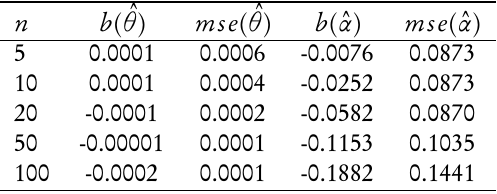
Bias and mean square error of the m.l.e.’s ( ˆ θ , ˆ α ) , for the intermediate binomial distribution { ˆ q ( θ , α ) } , with an approximation of the normalizing constant, θ = 0.5 , m = 20 , and α = 4.15 i